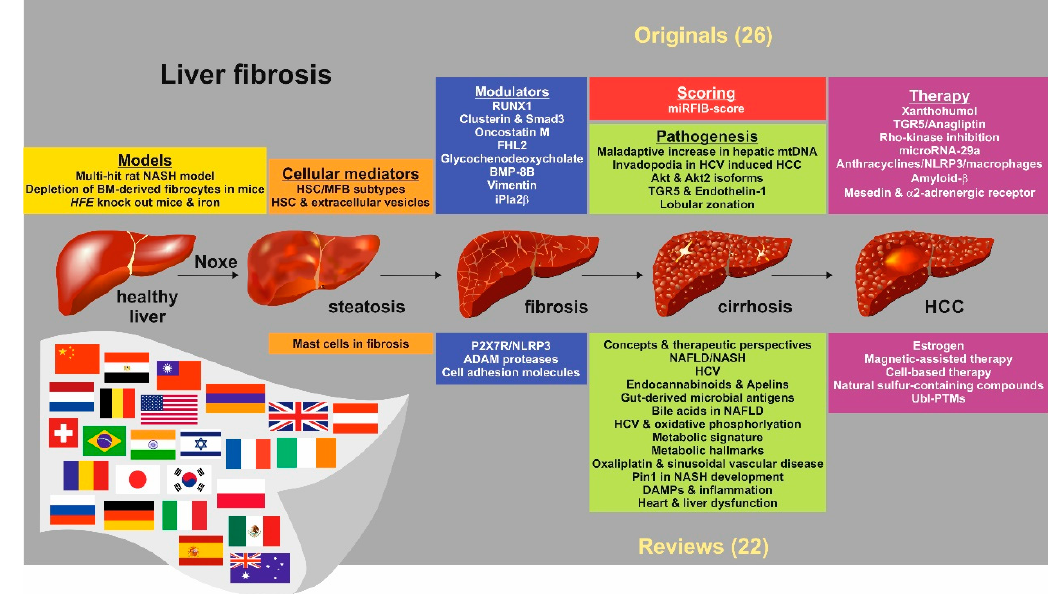
Figure 1. Topics covered in this Special Issue. The Special Issue “ Cellular and Molecular Mechanisms Underlying the Pathogenesis of Hepatic Fibrosis ” includes 26 original and 22 review articles written by 319 authors from 25 countries. These contributions discuss aspects of basic, clinical and translational research in the field of liver fibrosis. Special emphasis is given on the themes listed. Abbreviations used are: ADAM, a disintegrin and metalloproteinase; Akt1/2, serine/threonine-protein kinase 1/2;